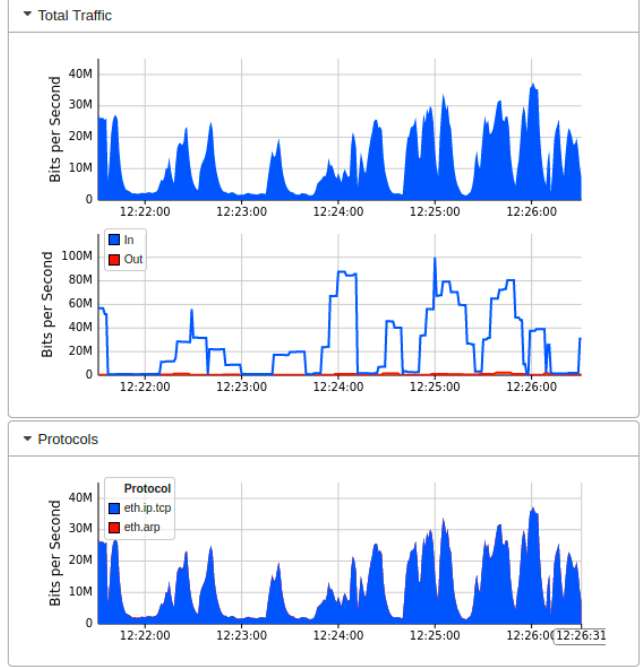
Figure 11. Network bandwidth dashboard during real-time DDoS attacks